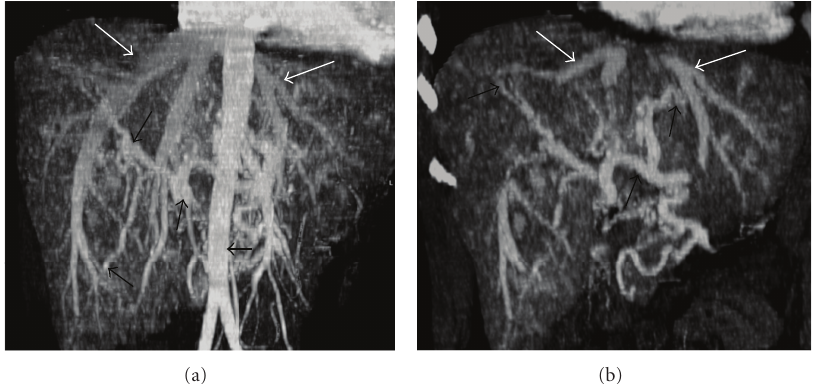
Figure 1: CT with coronal maximum intensity projection (MIP) reconstruction at early arterial phase (a, b) shows enlargement and early enhancement of the hepatic venous branch (white arrow), due to arteriovenous fistula and a large hepatic artery is also visible (black arrows). Abdominal aorta (arrowhead).